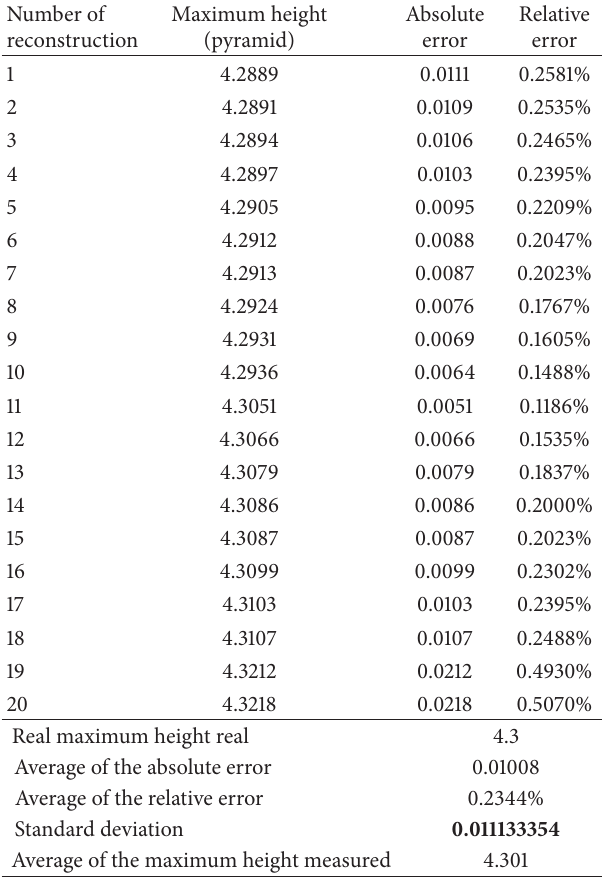
Table 2: Pyramid height